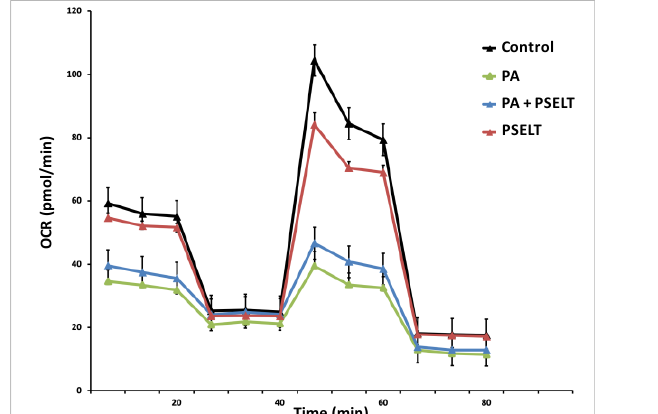
Fisher scientific) and a donkey anti-rabbit secondary antibody—Alexa Fluor™ 555 (red) (Invitrogen). Nuclei were counterstained with DAPI (blue). Scale bars: 25 µ m. Data are expressed as the mean ± SEM ( n = 3 different experiments). Significant differences in CTCF were detected by one-way